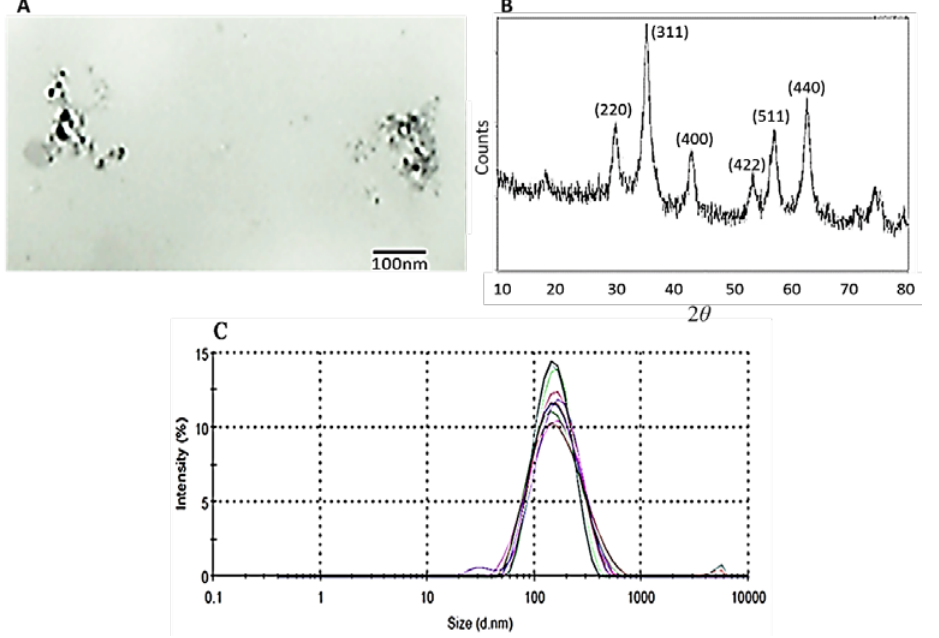
Figure 1. Characterization of paramagnetic nanobeads. ( A ) TEM micrograph of antibody-conjugated magnetic nanobeads. The multi-domain iron oxide cores from two nanobeads are visible. Bar size is 100 nm; ( B ) XRD pattern of antibody-conjugated magnetic nanobeads; ( C ) Size distribution of antibody-conjugated magnetic nanobeads is shown by a dynamic light scattering (DLS) graph. Ten replicates, as shown by peaks of different colours, were